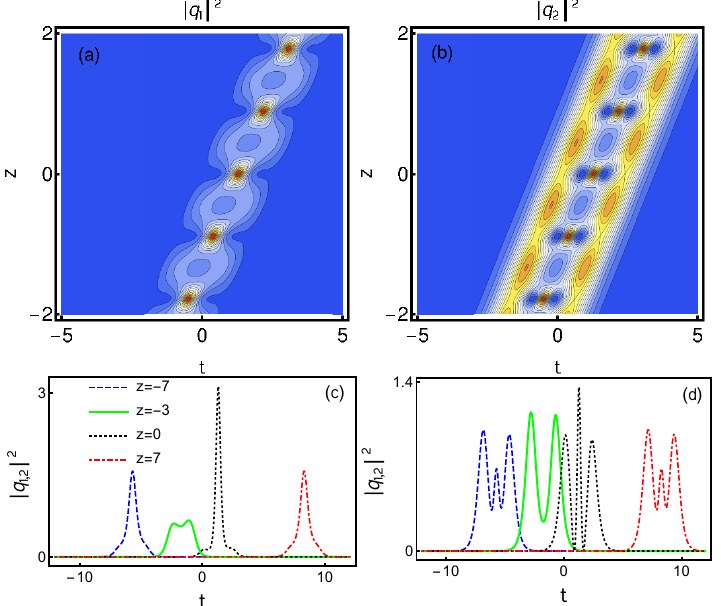
Figure 11. The figures ( a , b ) denote the contour plots of the breathing non-degenerate fundamental bright soliton of the 2-CCNLS system and the corresponding line plots are drawn for various z values in figures ( c , d